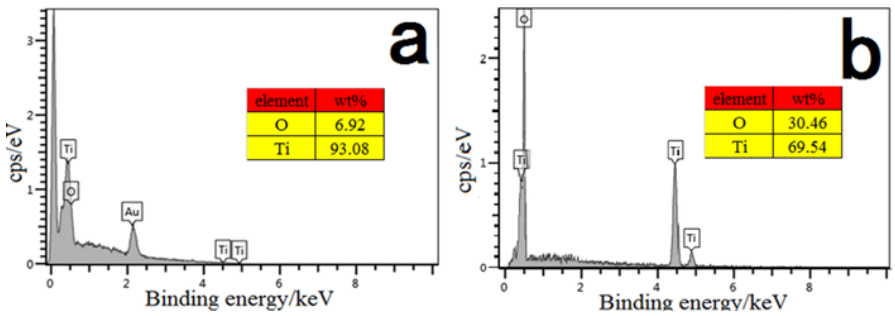
Figure 6. EDS spectra of the Ti wire ( a ) and the TiO 2 NTs/Ti fiber ( b ).